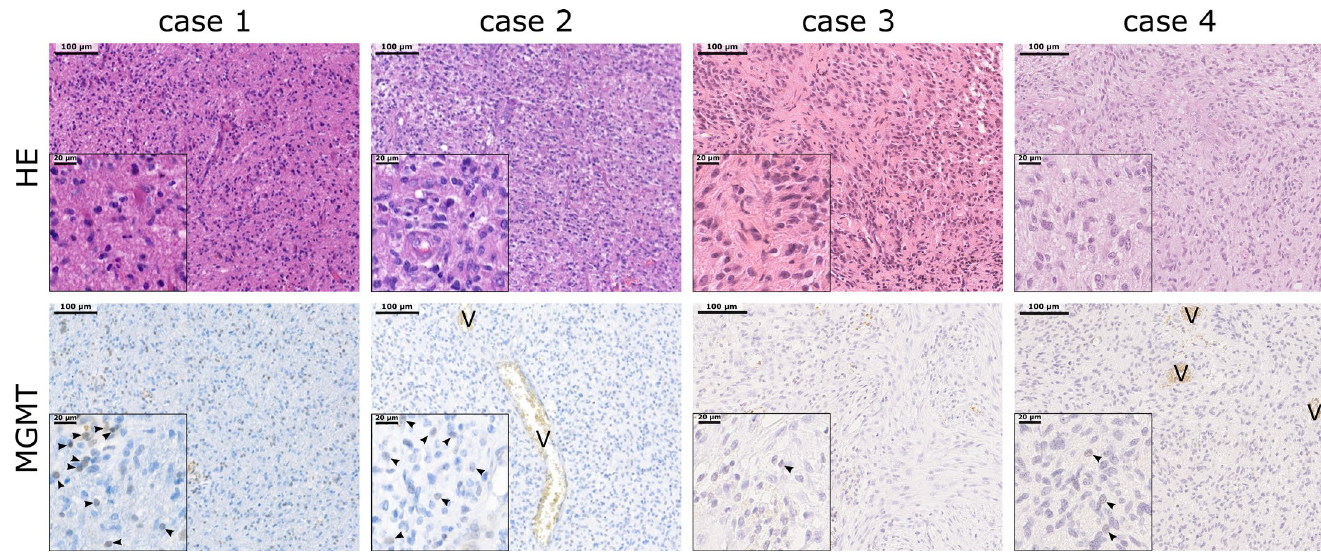
Figure 2. Representative images of the hematoxylin/eosin (HE) staining and the immunohistochemical staining for MGMT protein. Case 1 represents MGMT met+ /MGMT high , case 2 MGMT met− /MGMT high , case 3 MGMT met+ /MGMT low and case 4 MGMT met− /MGMT low . Images were taken using the Pannoramic Scan software v1.15.0.57 of a 3D Histech Scanner , and exemplary areas were determined via the Panoramic Viewer software v2.4.0.53492. Arrow heads indicate MGMT - positive cells. V = vessel; scale bar = 100 µm; insert scale bar = 20 µm.